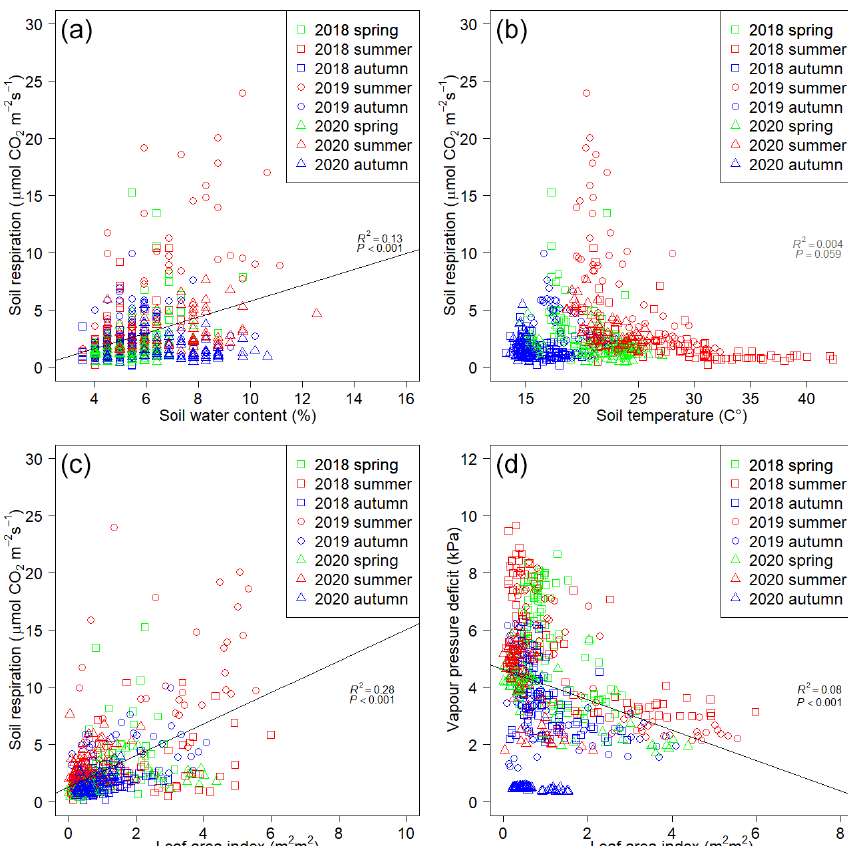
Figure 4. Relationships between variable pairs of the measurement campaigns. Pairs: soil respiration vs. soil water content (a) , soil respira- tion vs. soil temperature (b) , soil respiration vs. leaf area index (c) and leaf area index vs. vapor pressure deficit (d) . Table 3. Rates of soil respiration and its components with leaf area-index during the measurement campaigns. Campaigns Mean soil Heterotrophic Autotrophic Mean leaf R aut /mean respiration R s ( R het ) R s ( R aut ) area